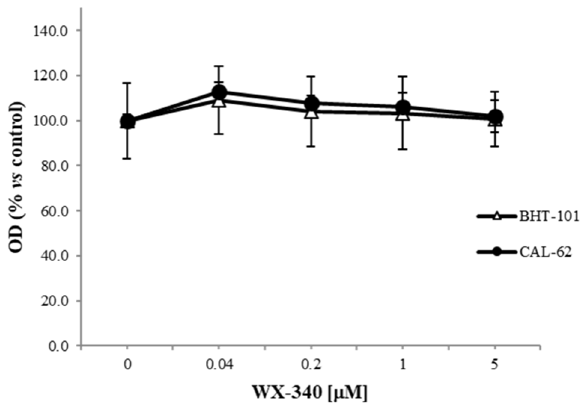
Figure 2. Dose-response proliferation assay. Cells were treated with increasing doses of WX-340 for 3 days, after which the tetrazolium salt WST-1 was added to cultures, and production of formazan dye was read after 2 h by microplate reader. The average absorbance value of each point at T = 72 h was subtracted to the average value measured in a plate at T = 0 h.